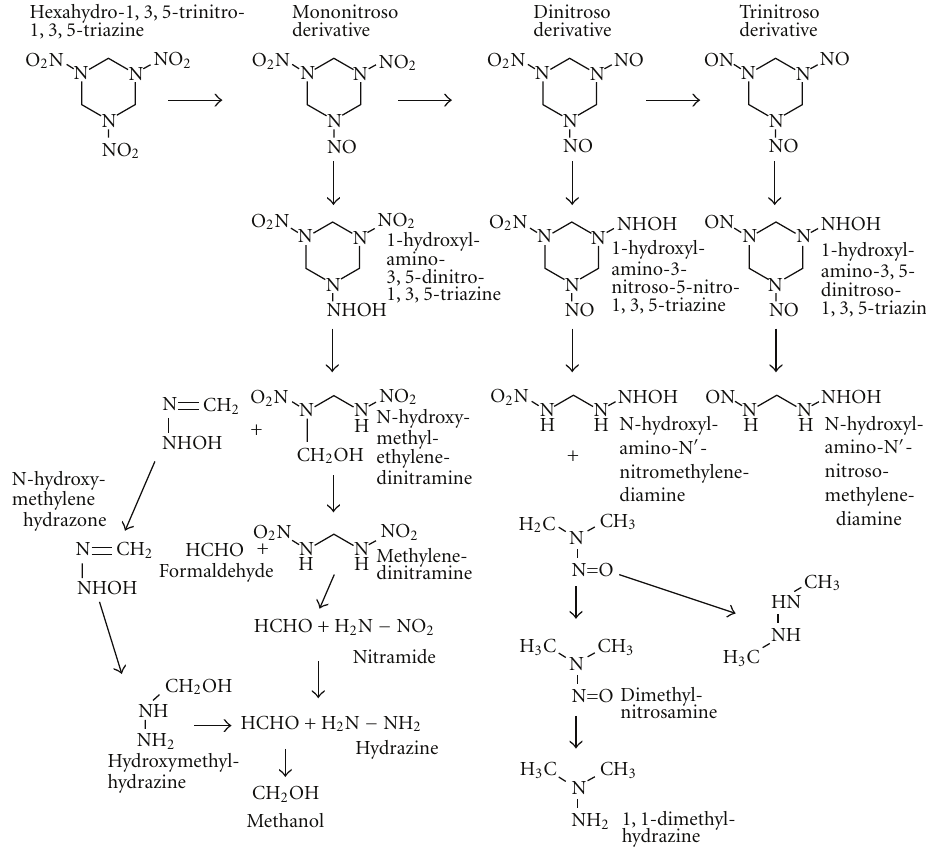
Figure 5: Biological transformation pathway of RDX